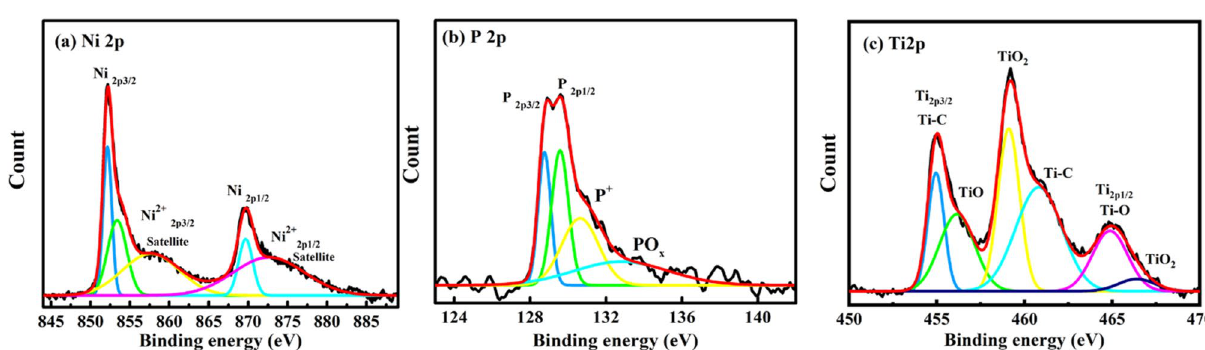
Figure 3. XPS spectra presenting the elemental composition of Ni–P/1.5 g L −1 TiC composite coatings, ( a ) Ni2p, ( b ) P2p and ( c )